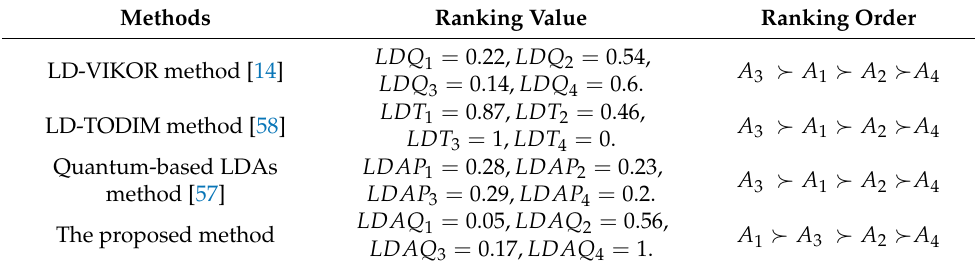
Table 13. The comparation with other